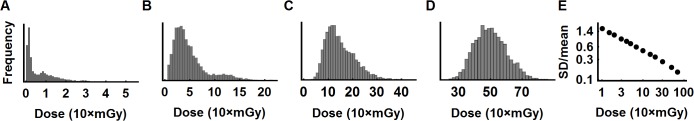
The ratio of standard deviation to mean dose (SD/mean) decreases with neuronal dose.Variability in neuronal dose between sampling trials for the same fluence dose (10, 50, 150, 500) mGy in panel (A) through (D) for 56Fe at 600 (MeV/u) are shown. The mean and SD values are (10.2, 50.5, 149.8, 499.5) mGy, (16.7, 36.3, 59.8, 98.0) mGy, respectively. The coefficient of variation (CV = SD/mean) is calculated as (1.64, 0.72, 0.40, 0.20) at these doses. As the statistical sampling is extended to other neuronal doses in panel (E) a power low relation indicates a straight line on a log-log scale plot.